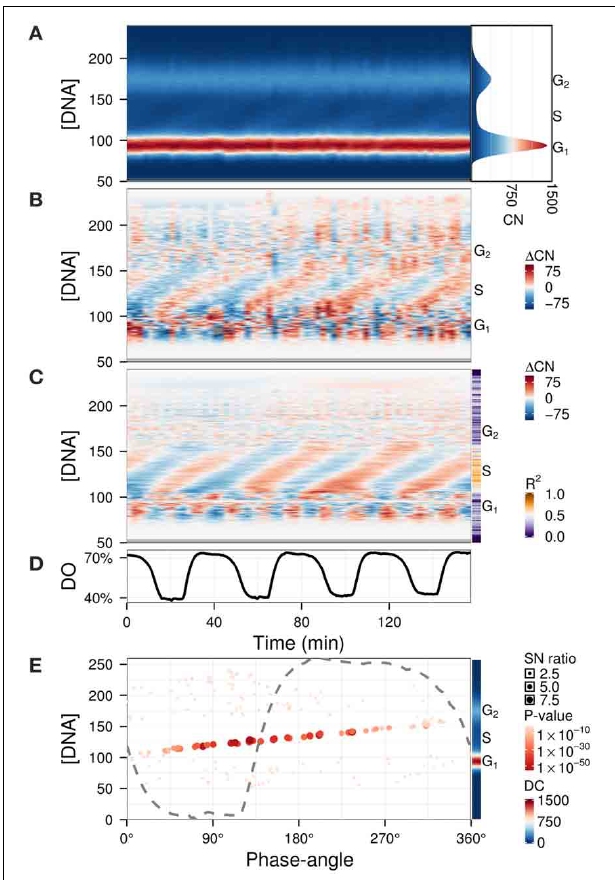
FIGURE 6 | Identification of phase-relationships in a flow cytometry dataset (Sasidharan et al., 2012a). Each datapoint represents the number of cells (CN) in a particular DNA intensity bin (peak propidium iodide channel) (Klevecz et al., 2004). These were aligned and scaled according to the G 1 and G 2 peaks ( A ; histogram of the average CN over the time-series is shown in right panel). Residuals (B) were calculated by subtracting the average CN over the time-series, and were filtered using the waveform algorithm ( C ; R 2 values shown in sidebar). The corresponding dissolved oxygen (DO) trace during the experiment is shown in (D) . The major component (4 cycles) was characterized by the phase-angles with respect to the respiratory oscillation and SN ratio at each DNA concentration (E) ; the DC component is shown in the sidebar. The dashed gray line represents the DO trace over one cycle, scaled to the range of the panel. Phase-angles 0 ◦ /360 ◦ represent the minimum of the DO rate in each respiratory